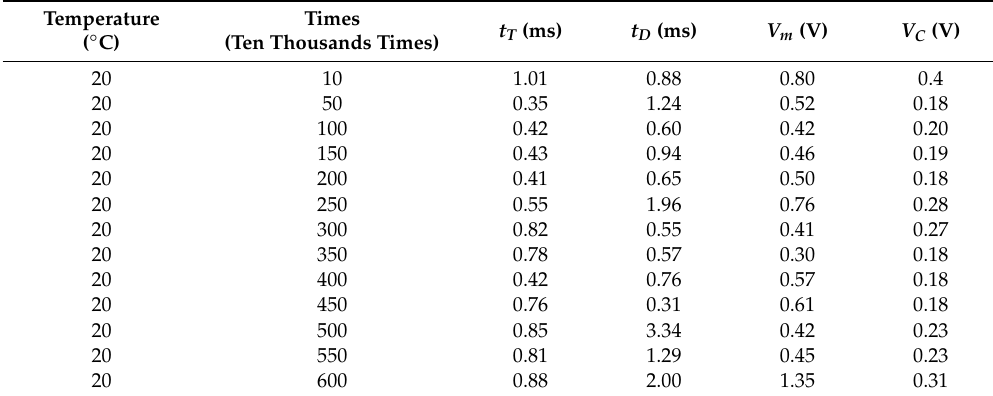
Table 3. Experimental results of relay at 20 ◦ C.